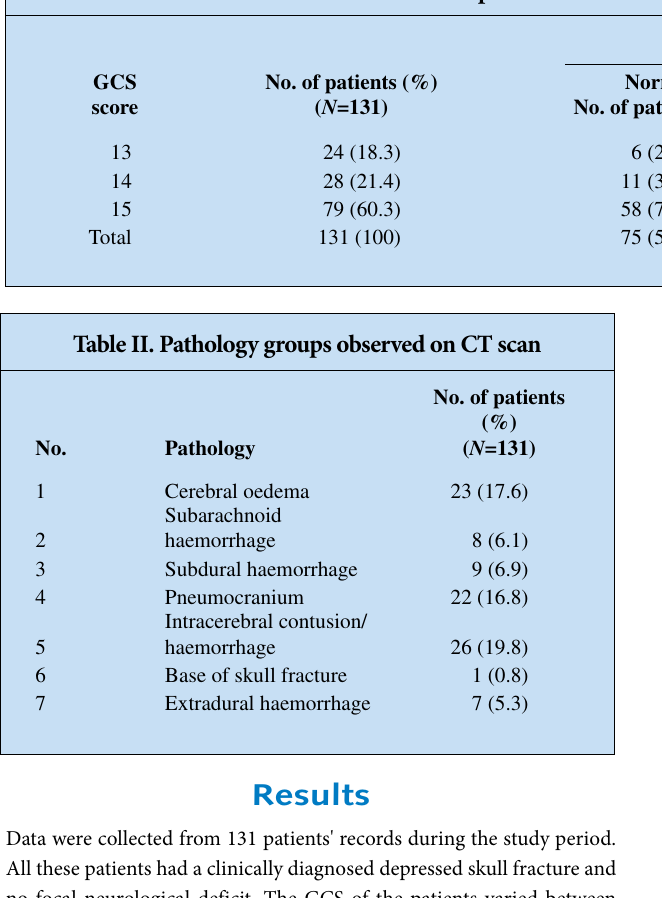
Table I. Number of patients and abnormal CT scan findings per GCS